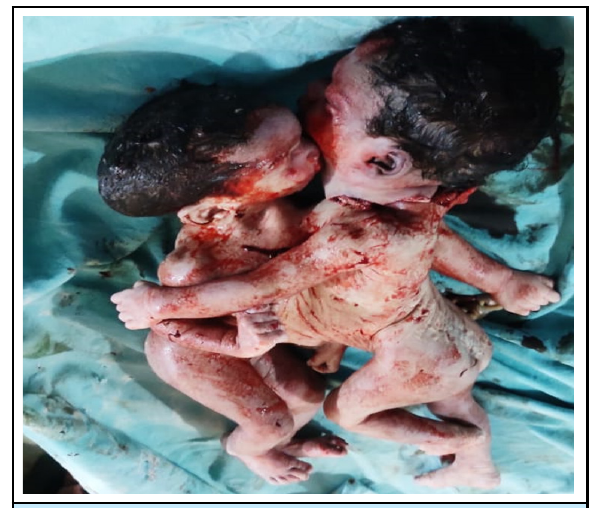
Figure 3. Conjoined twin - Thoracophagus